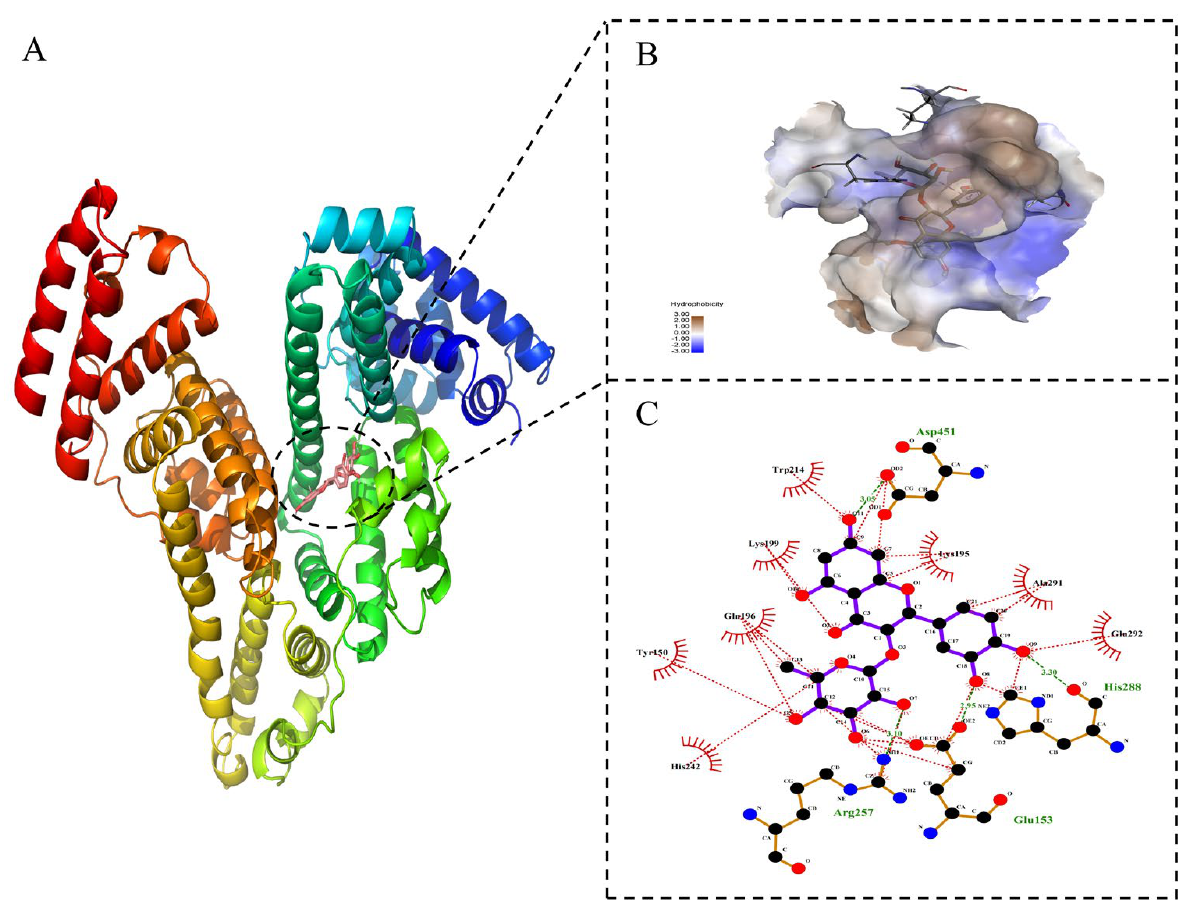
Figure 7. Molecular docking diagram of astilbin–HSA system. (( A ) Molecular docking map of astilbin binding site I on HSA; ( B ) astilbin located in the hydrophobic cavity of site I; ( C ) 2D diagram of the interaction of HSA with astilbin.).